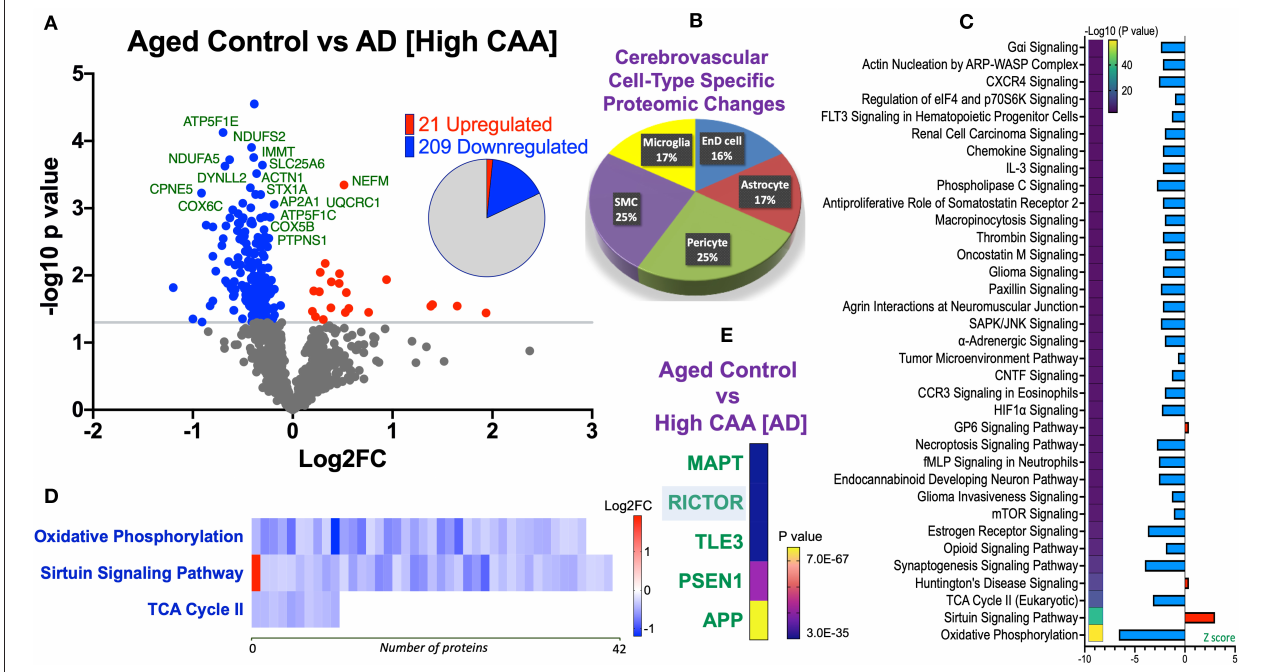
FIGURE 6 | Proteomic changes, cell origin, signaling pathways, upstream regulator factors observed from the cerebrovasculature isolated from the inferior frontal gyrus of high CAA vs. aged-matched control cases. (A) Volcano plot of differentially expressed proteins in high CAA vs. aged-matched control cases (pie chart inset shows up/down-regulated proteins, significant cut off set at 1.3 and red and blue points indicated up- or down-regulated significant proteins, respectively). (B) Pie Chart show origin of cell types where significant proteins from the comparisons between high CAA vs. aged-matched control cases are observed. Data are generated from the number of significantly regulated proteins per specific cell type (from the PanglaoDB omic database), expressed as a percentage. (C) Canonical pathways identified from ingenuity pathway analyses [data depict –log10 ( P -value) and Z score generated from Fischer test of an overlap with the IPA knowledgebase; blue—downregulated and red—upregulated], and (D) shows heat map of the top 3 pathways and the corresponding number of significantly regulated proteins altered per pathway and their Log2 fold change expression level. (E) Shows Top 5 identified upstream regulators from the ingenuity pathway analyses of differentially regulated proteins in high CAA vs. aged-matched control cases ( light blue highlighted text indicates that the upstream regulator is predicted to be activated ).